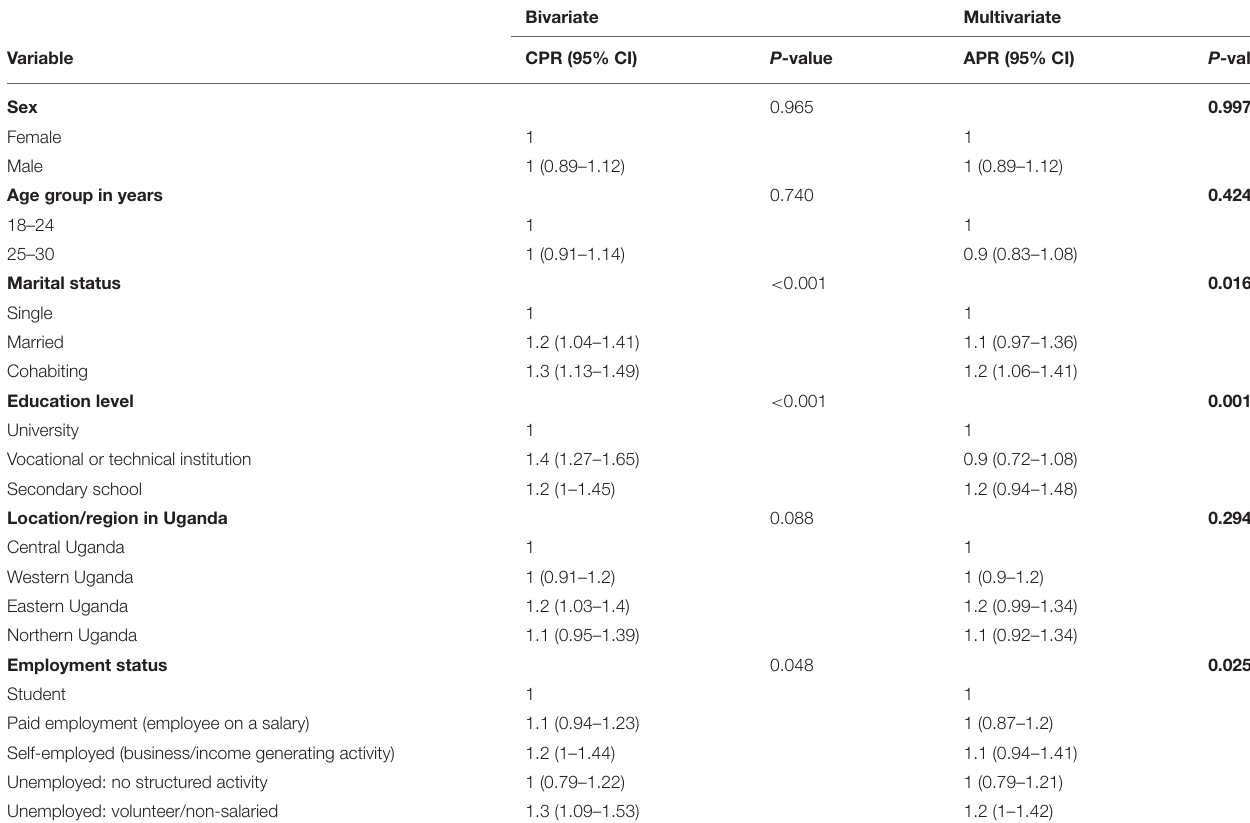
TABLE 3 | Bivariate and multivariate regression analyses using poisson regression of having a limiting factor to access SRH among Ugandan youth with their social demographics during the COVID-19 lockdown.